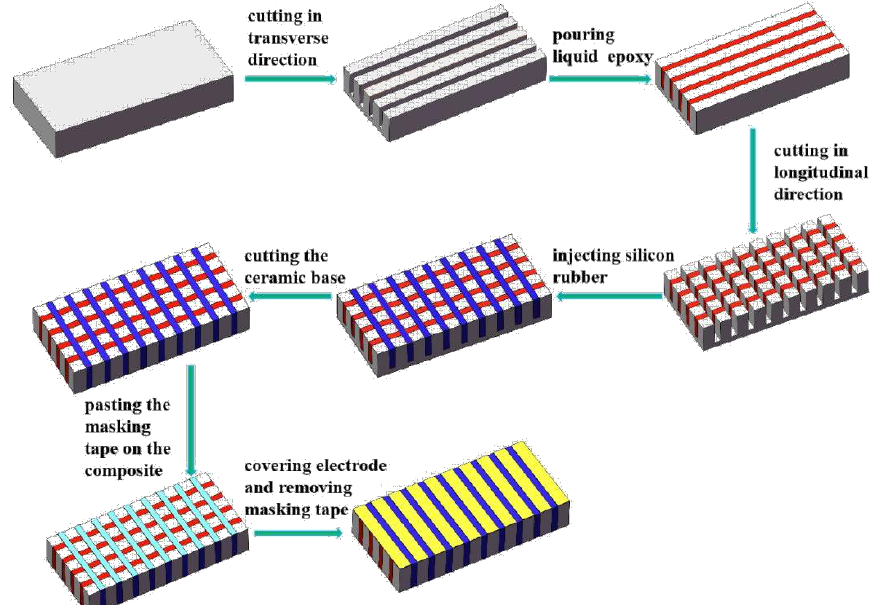
Figure 6. Fabrication method of the two-phase 1–3 piezoelectric composite array.